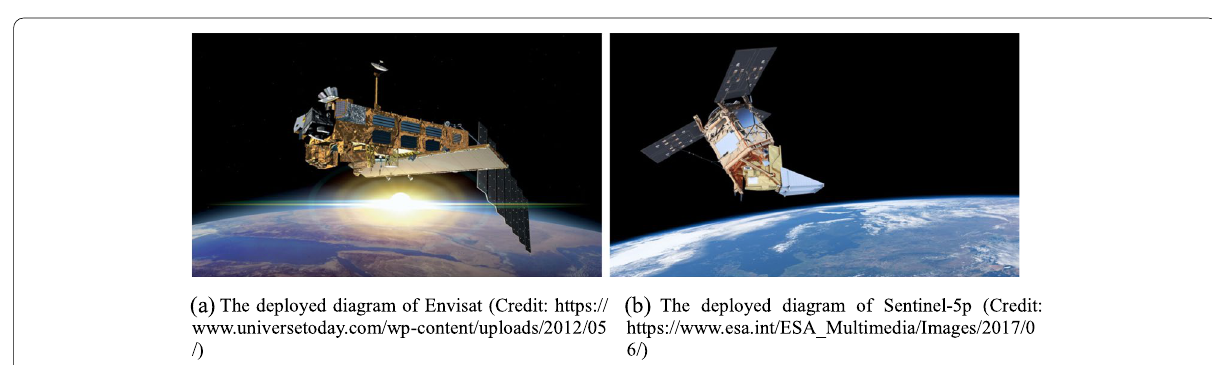
Fig. 4 Artist’s rendition of deployed Envisat and Sentinel-5p. a The deployed diagram of Envisat (Credit: https:// www. unive rseto day. com/ wp- conte nt/ uploa ds/ 2012/ 05/). b The deployed diagram of Sentinel-5p (Credit: https:// www. esa. int/ ESA_ Multi media/ Images/ 2017/ 06/)